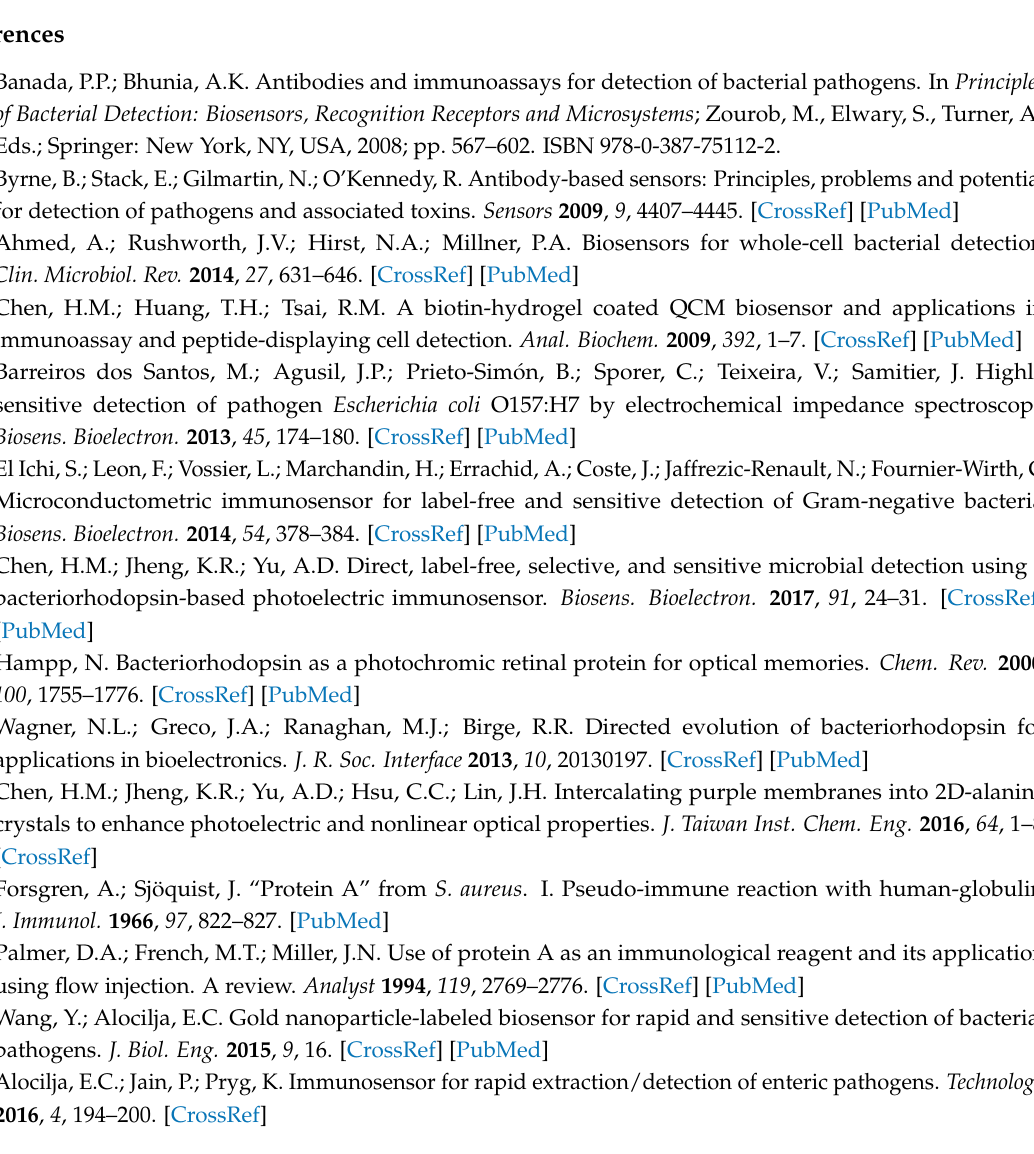
OA, a mixture of GO and OA (1:5 weight ratio), and pure GO, Table S2: Raman-band (cm -1 ) assignment for the ITO electrodes fabricated with different topmost layers, Table S3: Effects of prior microfluidic washing on the relative averages and relative standard deviations (RSDs) of the total photocurrent densities of the chips fabricated with different topmost layers, Table S4: Comparison of various selective SpA-based immunosensors for microbial detection, Table S5: Sensitivity of E. coli , L. acidophilus , and S. mutans immunosensing chips on the detection of pure E. coli K-12, L. acidophilus , and S. mutans cultures, respectively, in different ranges of cell concentration, Table S6: Ratios of the peak photocurrent values between the light-on and light-off responses of the chips fabricated with different topmost layers for the detection of different